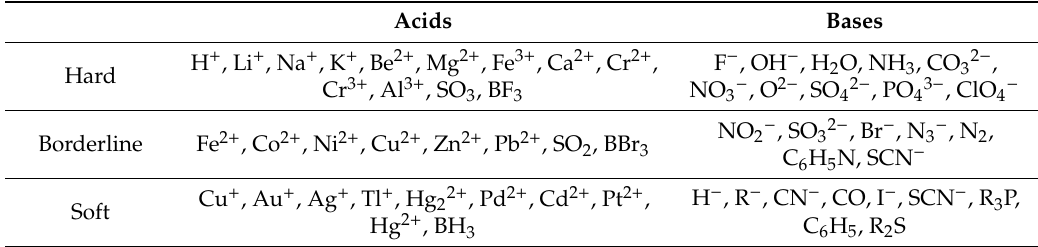
Table 1. Classification of Lewis acid and bases according to the Hard and Soft Acid and Bases (HSAB) theory.